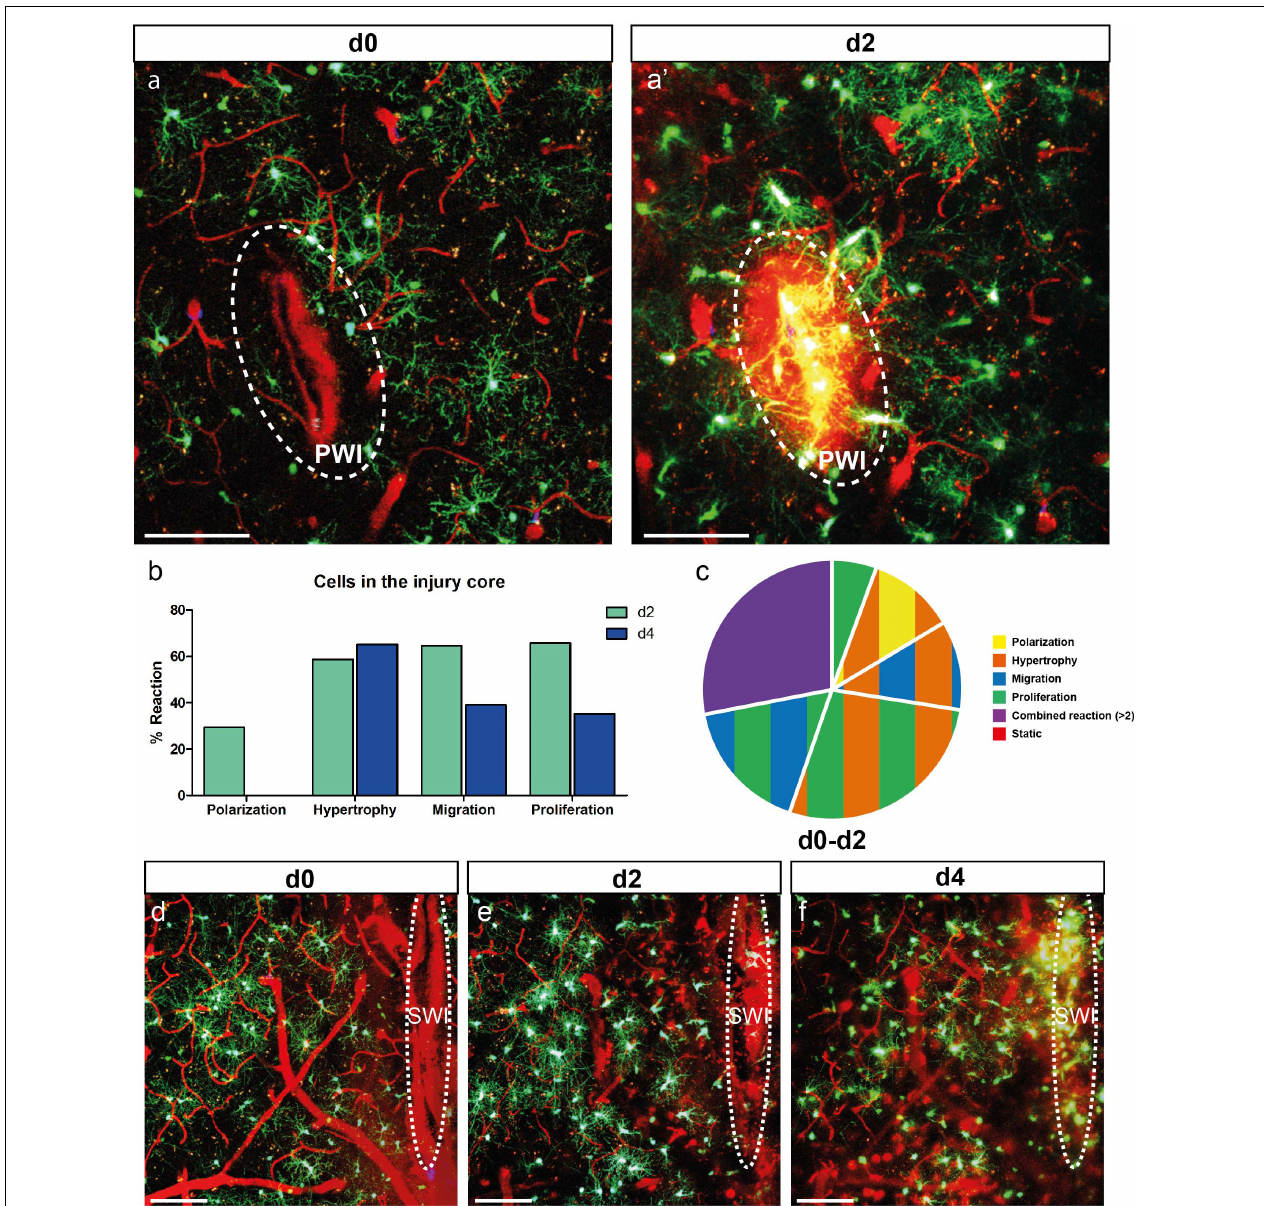
FIGURE 4 | NG2-glia fill the injury core. (a) Images of NG2-glia at d0 (a) and d2 (a’) after PWI. Dotted circle indicates the core of the injury that corresponds to the analyzed area. (b) Graph showing a strong reactivity of these cells for all criteria (except polarization) at d2 and d4 after injury. (c) Pie chart of the heterogeneous reaction between 0 and 2dpi of NG2-glia showing no static cells (Polarization represents cells directed toward the injury; n = 34 cells from 7 animals for d2 and n = 23 cells from 4 animals at d4). Images show maximal projections of 20 µ m deep stacks. Scale bars represent 100 µ m. (d–f) Images of 0, 2 and 4 days after SWI showing NG2-glia only filling up the injury core at 4dpi. White ellipse represents the injury site. Images show maximum intensity projections of 30 µ m deep stacks. Scale bars represent 100 µ